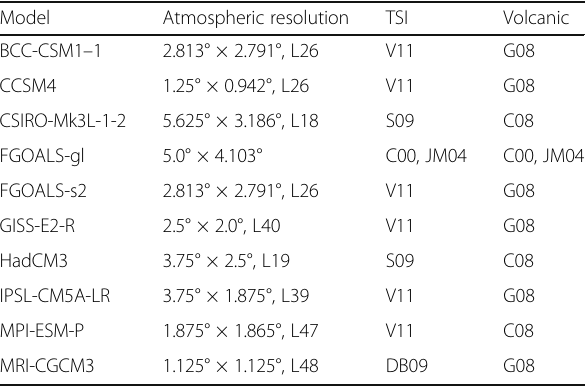
Table 1 List of PMIP3 models used in this study. The TSI and volcanic columns indicate forcing data sets prescribed in the models. V11: Vieira et al. (2011), S09: Steinhilber et al. (2009), C00: Crowley (2000), JM04: Jones and Mann (2004), DB09: Delaygue and Bard (2009), G08: Gao et al. (2008), C08: Crowley et al. (2008) Model